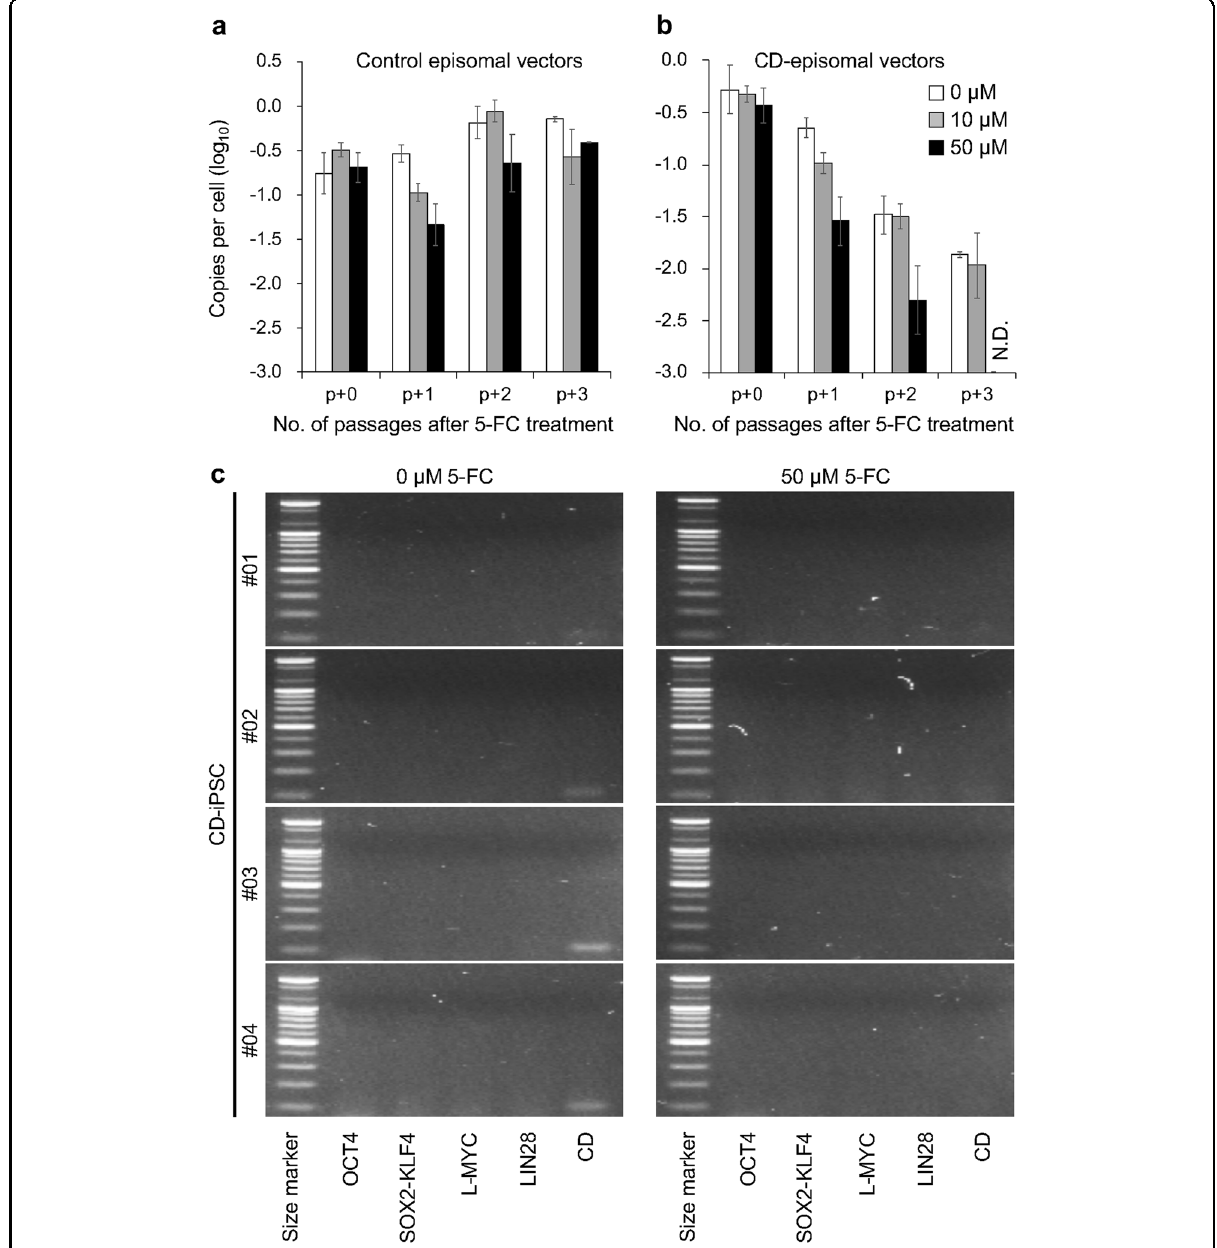
Fig. 3 Rapid elimination of residual CD episomal vectors in human iPSCs. A qPCR analysis was used to measure the copy numbers of the remaining episomal vectors in control-iPSCs ( a ) and CD-iPSCs ( b ) during serial culture with or without 5-FC. N.D. indicates not detected. In these experiments, the control- and CD-iPSC samples used were mixtures of nine independent iPSC colonies. c A PCR analysis was used to detect the exogenously introduced reprogramming factors and the CD gene. Total DNA from CD-iPSC #01, #02, #03, and #04 with or without 5-FC treatment was used as a template. A 100 bp size marker ladder (Bioneer) was